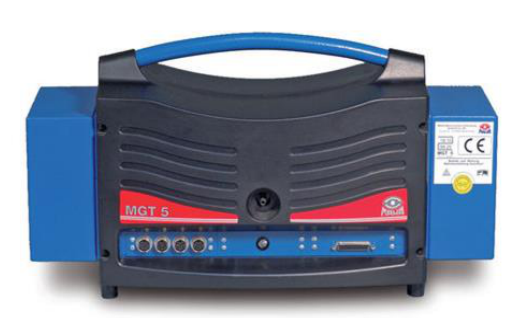
Fig. 1. Test stand with BMW M10B18 engine